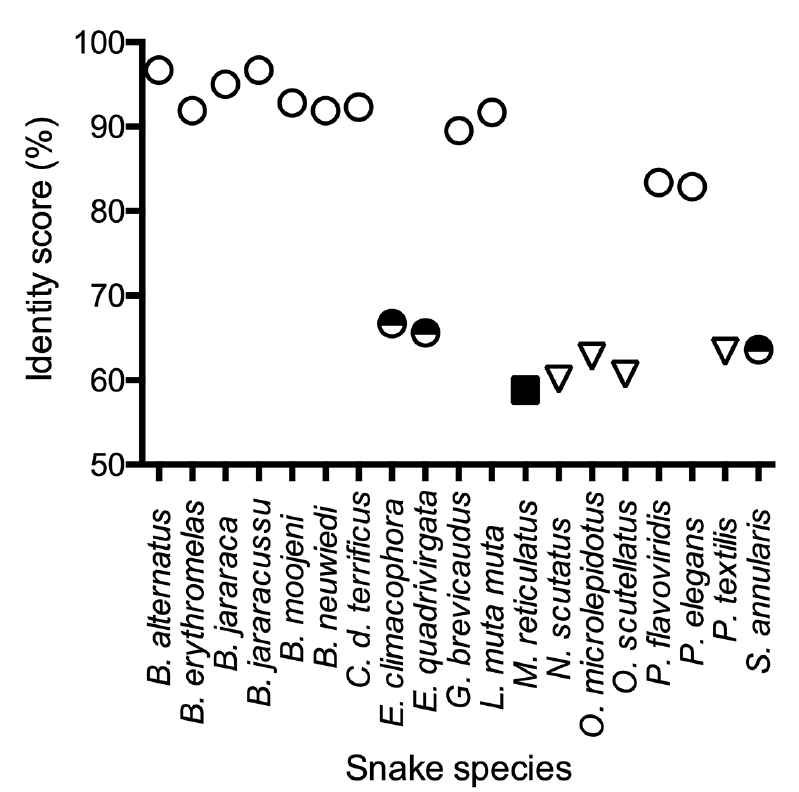
Figure 9. Graphical representation of the identity scores (ISs) obtained in Gonnet’s similarity matrix after multiple alignment of the deduced primary structure of BcNF with known sbγPLIs. Black/white circle: Colubridae, white triangle: Elapidae, white circle: Viperidae, black rectangle: